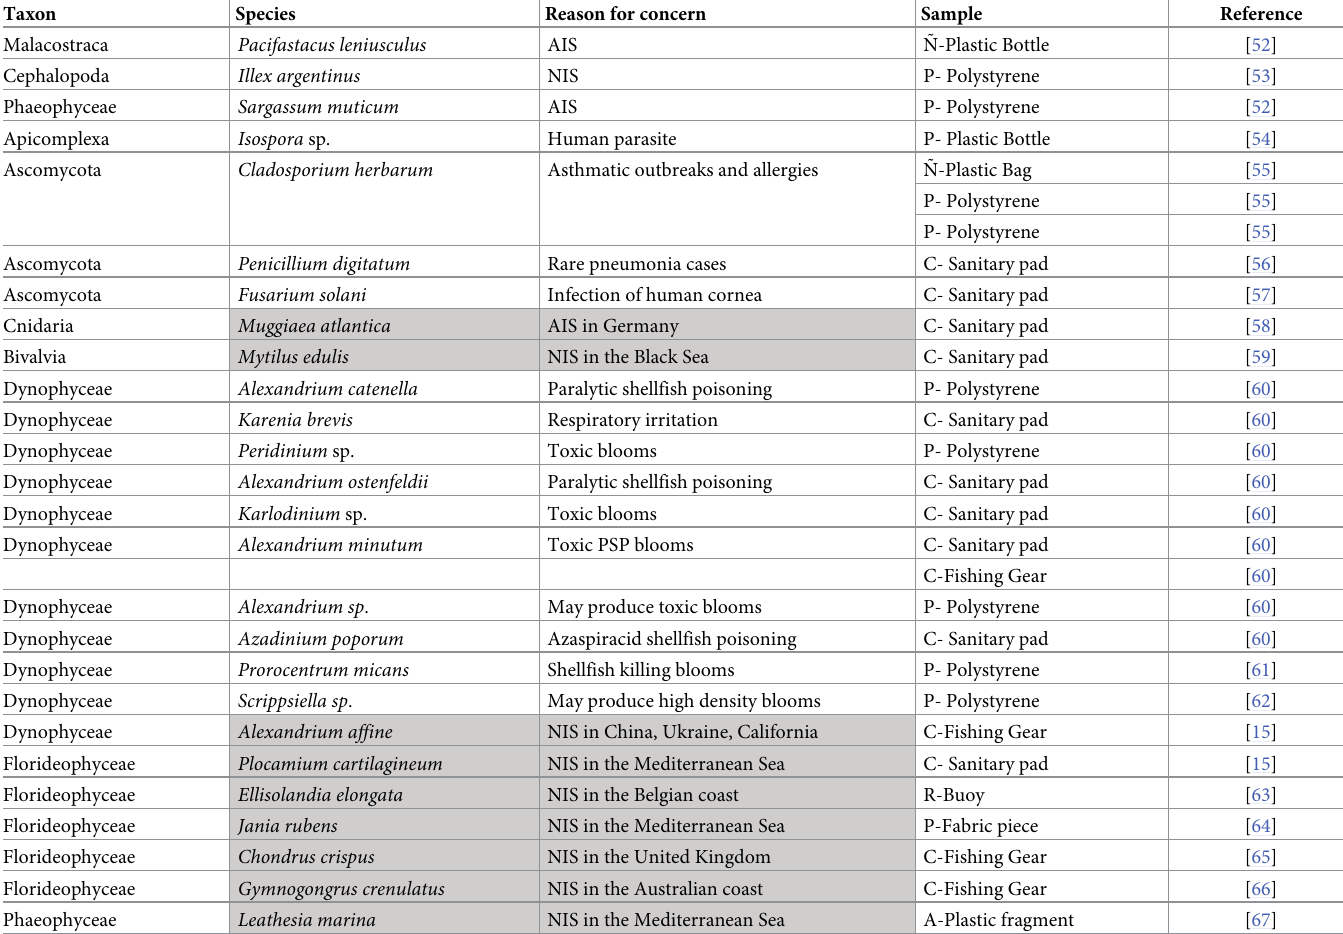
Table 3. Non-indigenous and nuisance species which DNA was found attached to beached litter objects; Shaded in grey, species native from the study region that have been described as NIS or AIS